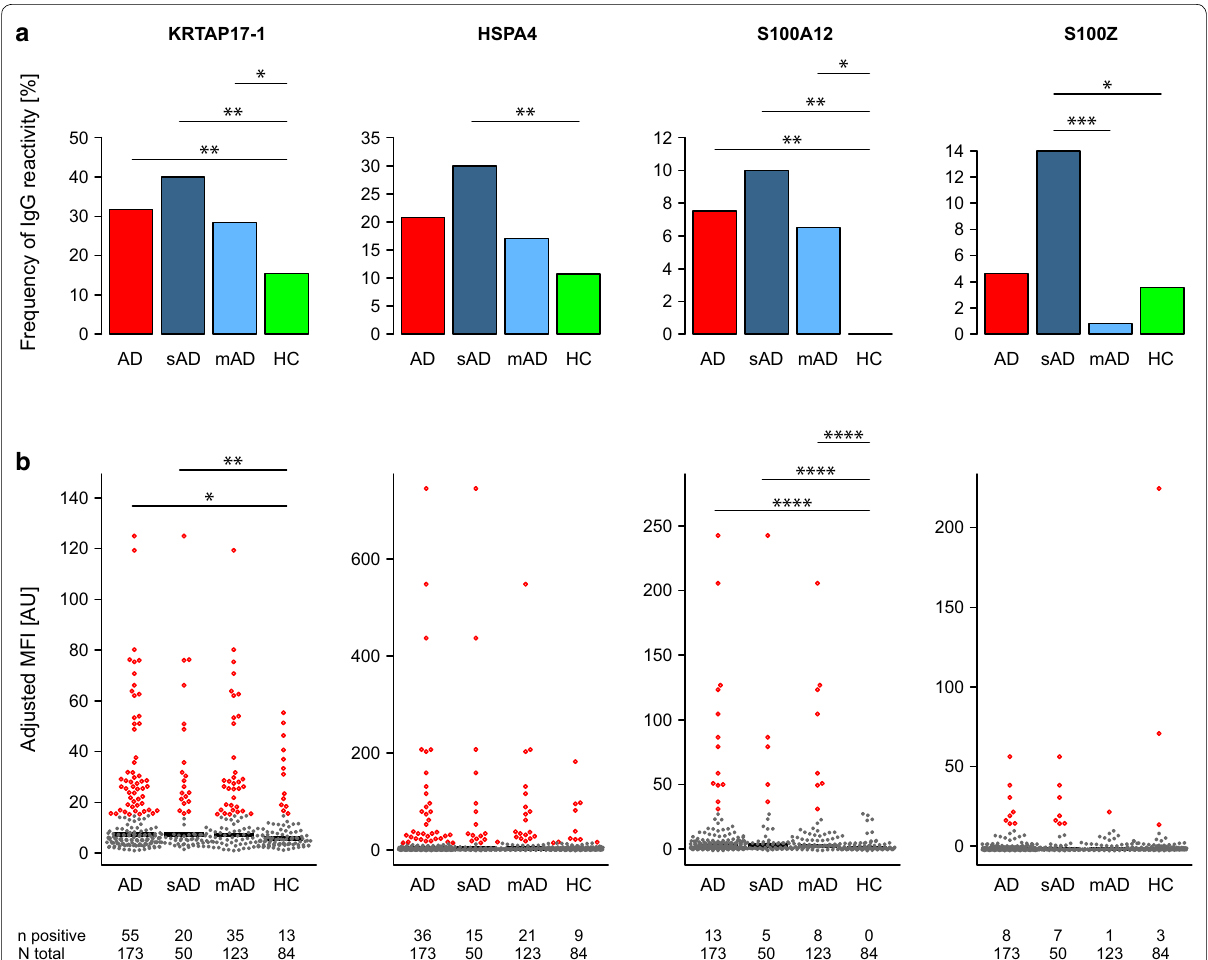
Fig. 2 Antigens showing significant difference in IgG-reactivity between healthy controls (HC) and atopic dermatitis patients (AD) or between HC and moderate (mAD) and/or severe (sAD) atopic dermatitis patients when analyzed using antigen bead arrays. a The frequency (%) of subjects with IgG-reactivity to KRTAP17-1, HSPA4, S100A12 and S100Z. b The adjusted median fluorescence intensity (MFI) of all subjects with positive reactivity highlighted in red. Adjusted MFI was defined as the sample median across all protein fragments subtracted from each signal and divided by the MAD. The number of subjects with positive reactivity out of the total is indicated below each figure. Significant P values of pairwise group comparisons indicated by * P < 0.05, ** P < 0.01, *** P < 0.001, **** P < 0.0001, Fisher’s exact test ( a ) and Wilcoxon-rank sum test ( b